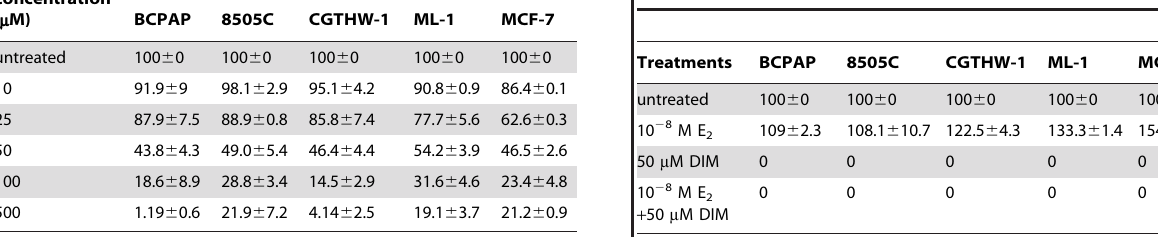
Table 2. DIM inhibits clonogenicity of thyroid